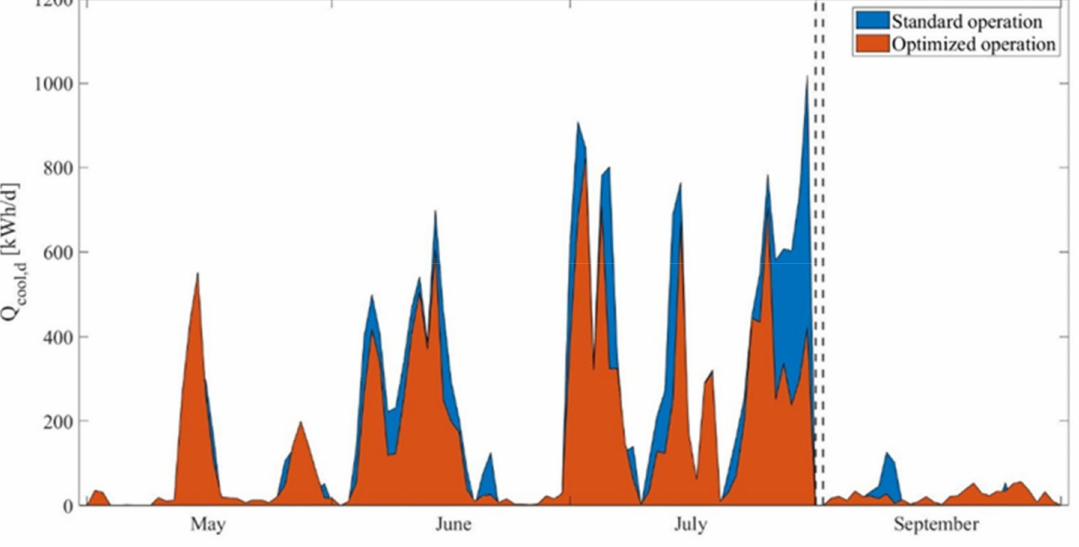
Figure 11. Evolution of the daily cooling demand according to the “standard” and the “optimized”